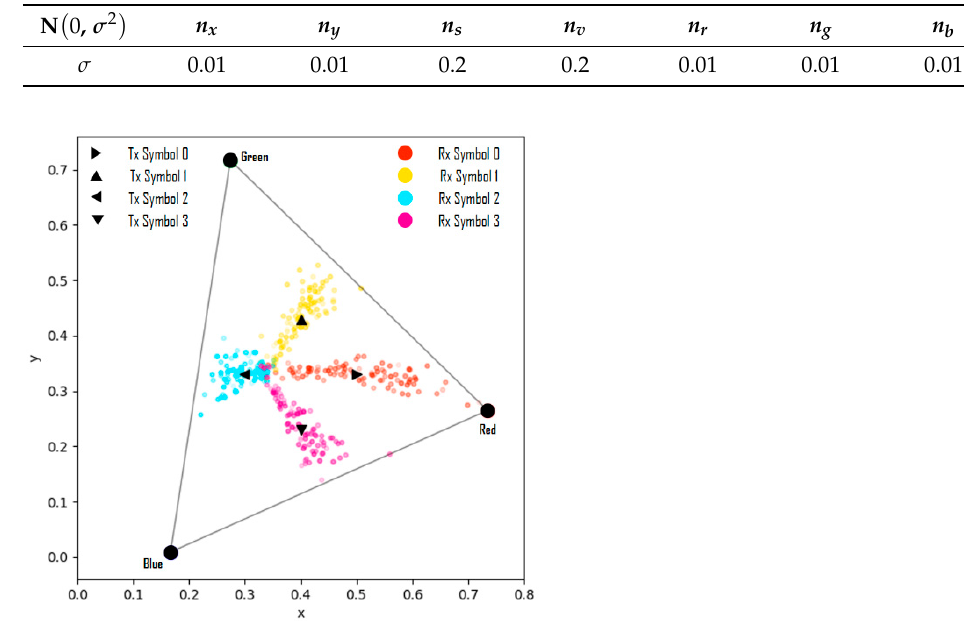
Figure 10. Symbol transmission/reception simulation results from channel modeling.